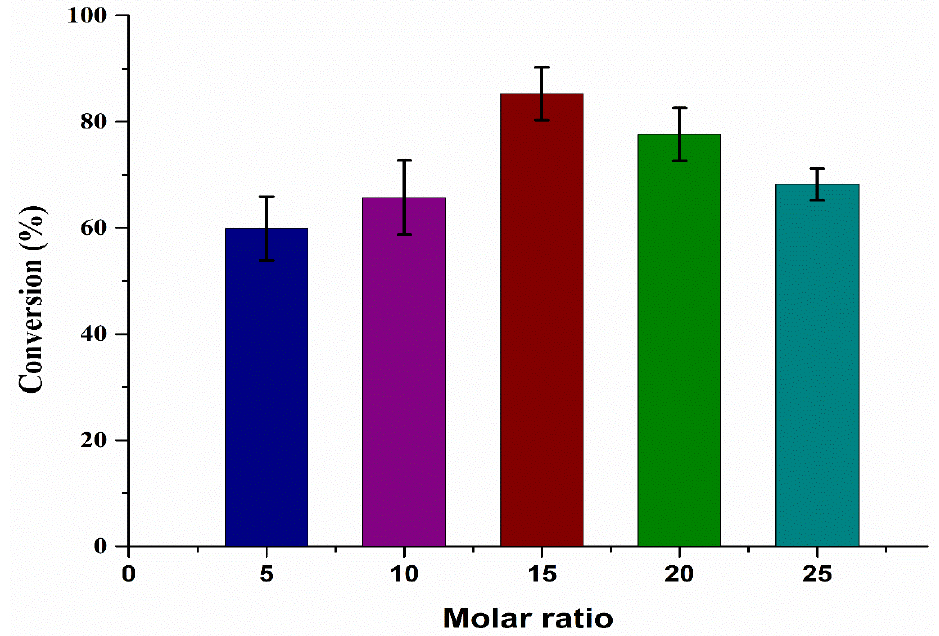
Figure 3. Effect of molar ratio (WCO/MeOH = 1:5 to 1:25) on biodiesel production.